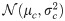
Distribution of effective odorant concentration for the activation of partner receptors.a. Histogram of EC50 calculated for all dose-response data (gray). Among the 535 interacting odorant-receptor pairs, 475 pairs exhibit activation (δSmax > 0, red), and the remaining pairs show deactivation (δSmax < 0, cyan). Note that the red and cyan distributions sum to make the gray (all pairs) distribution. The EC50 values for the pairs exhibiting activation can be fitted effectively to a Gaussian N(μc,σc2) [42] with μc = −3.6 and σc = 1.1; for all pairs, μc = −4.0 and σc = 1.8. The skewness of the distribution is likely to be contributed from the extremal (cutoff-based) nature of the measurement, which unavoidably eliminates the weakly interacting (high EC50) pairs from the data. The deactivating pairs are characterized with a broader distribution of EC50 values. The super-strong binders (EC50 < −9) are exclusively contributed by those among the odorant-receptor pairs demonstrating the deactivation. b. Odorant-specific differential response for the top five broadly-interacting odorants.